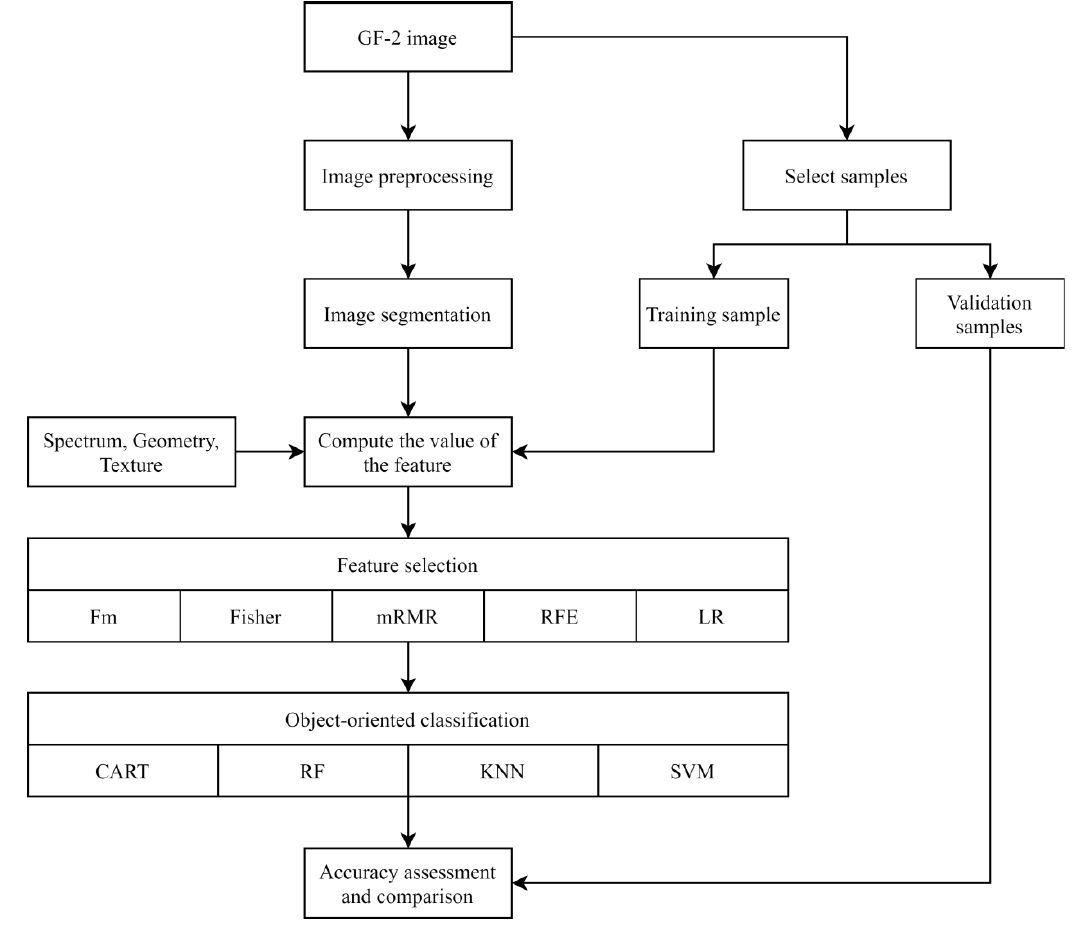
Figure 2. Technical flow chart.